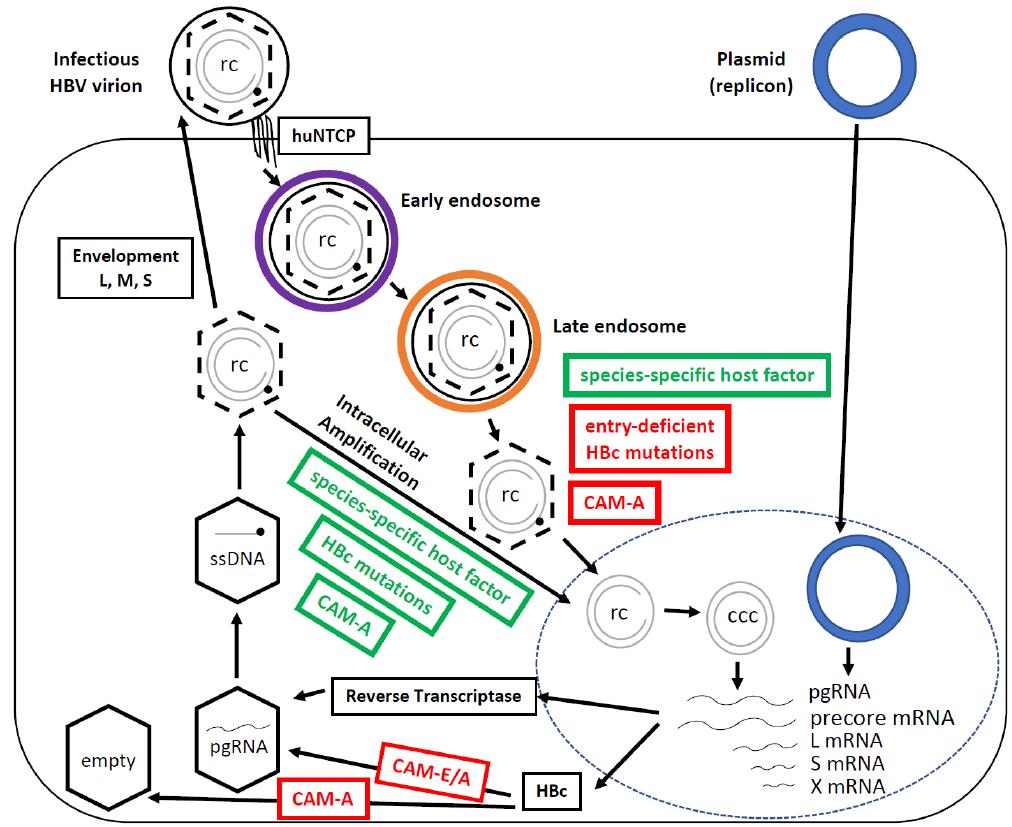
Figure 1. The simplified HBV lifecycle. HBV is endocytosed, traffics through the early (purple) and late (orange) endosomal compartments, undergoes cytosolic release and nuclear import to deliver rcDNA to the nucleus, where it is converted to cccDNA. Transcription and translation then occur, and nucleocapsid packaging of pgRNA and conversion to rcDNA ensues. rcDNA-containing nucleocapsids can be enveloped and secreted or cycled back to the nucleus to make more cccDNA (intracellular amplification). The dashed lines of capsids (hexagons) denote associated capsid destabilization